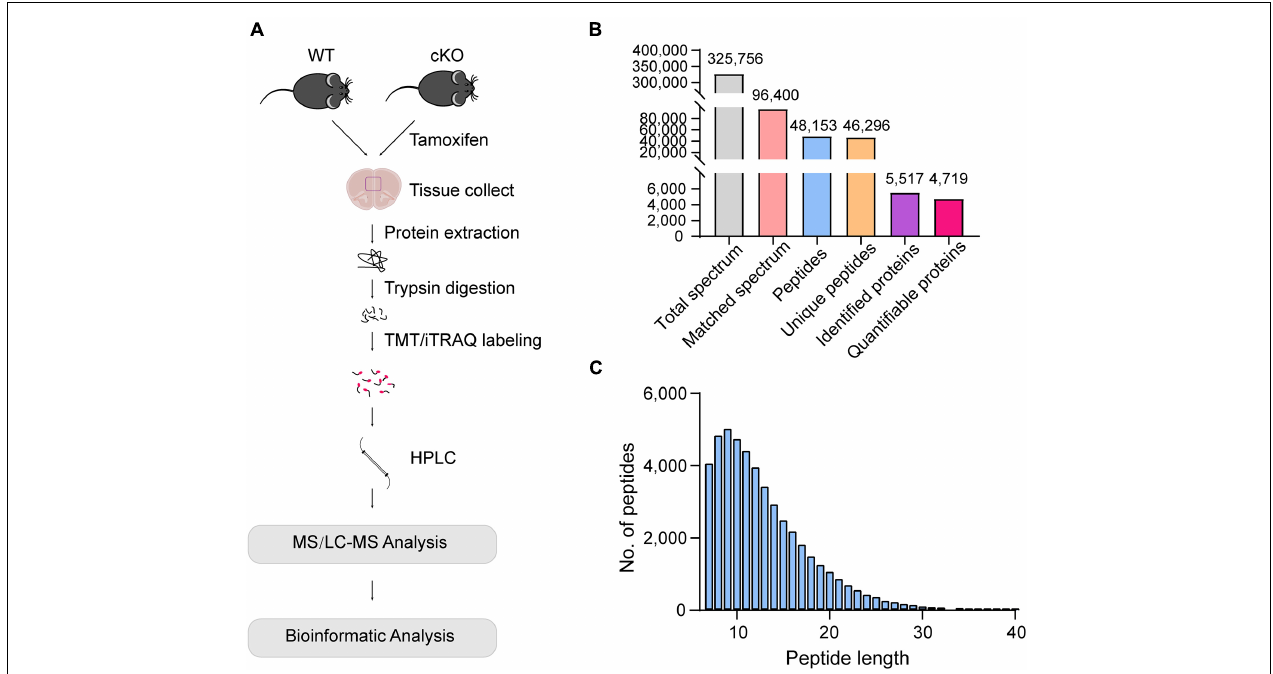
FIGURE 2 | Protein identification and quantification in the mPFC of astrocyte-specific OGT knockout mice. (A) Schematic of the proteomics analysis in the mPFC of astrocytic OGT cKO and WT mice. (B) Basic information of MS data. (C) The distribution of peptide